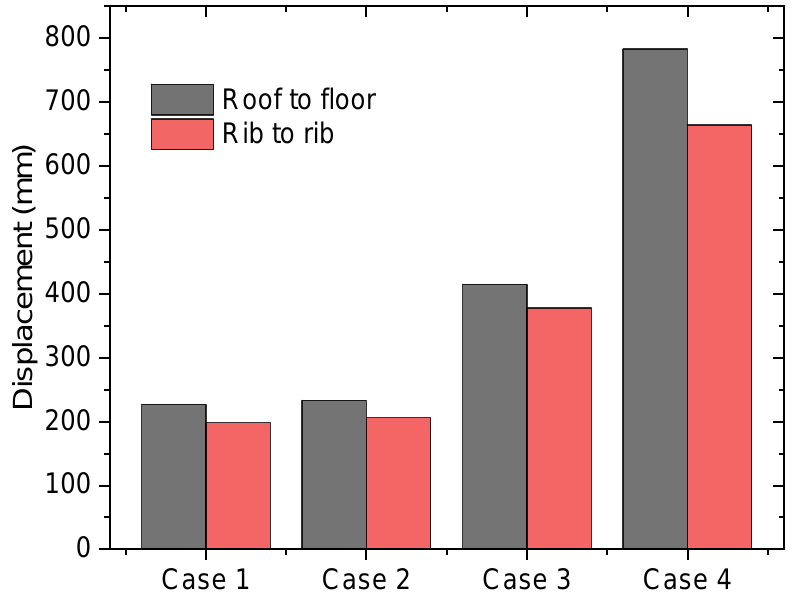
Figure 9. Deformation law on the roadway surface.